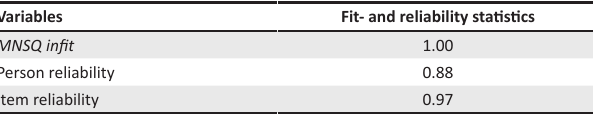
TABLE 1: Summary of Rasch analysis.